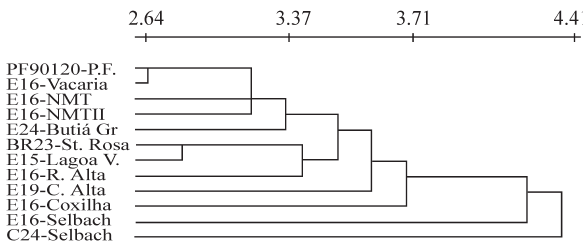
Figure 5 - Dendrogram of the relationships between Drechslera tritici-repentis isolates based on both colony morphology and random am- plified polymorphic DNA (RAPD)